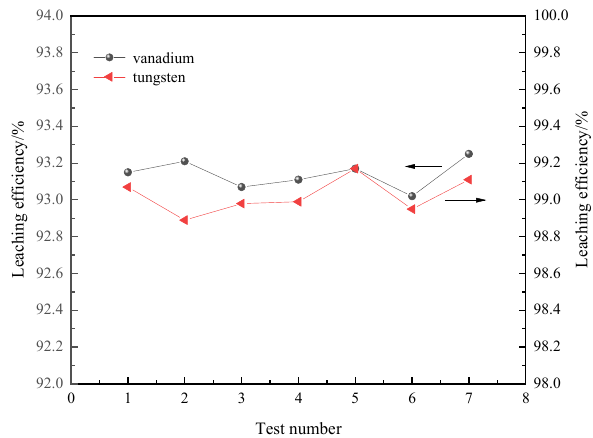
Figure 8. The leaching efficiencies of V and W under the optimal roasting